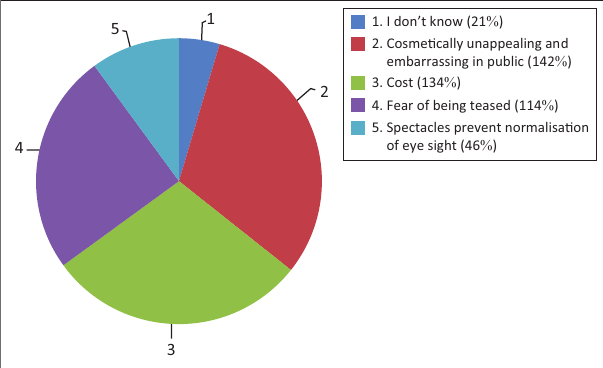
FIGURE 4: Participants’ opinion about the reasons why students with poor vision do not wear spectacles.